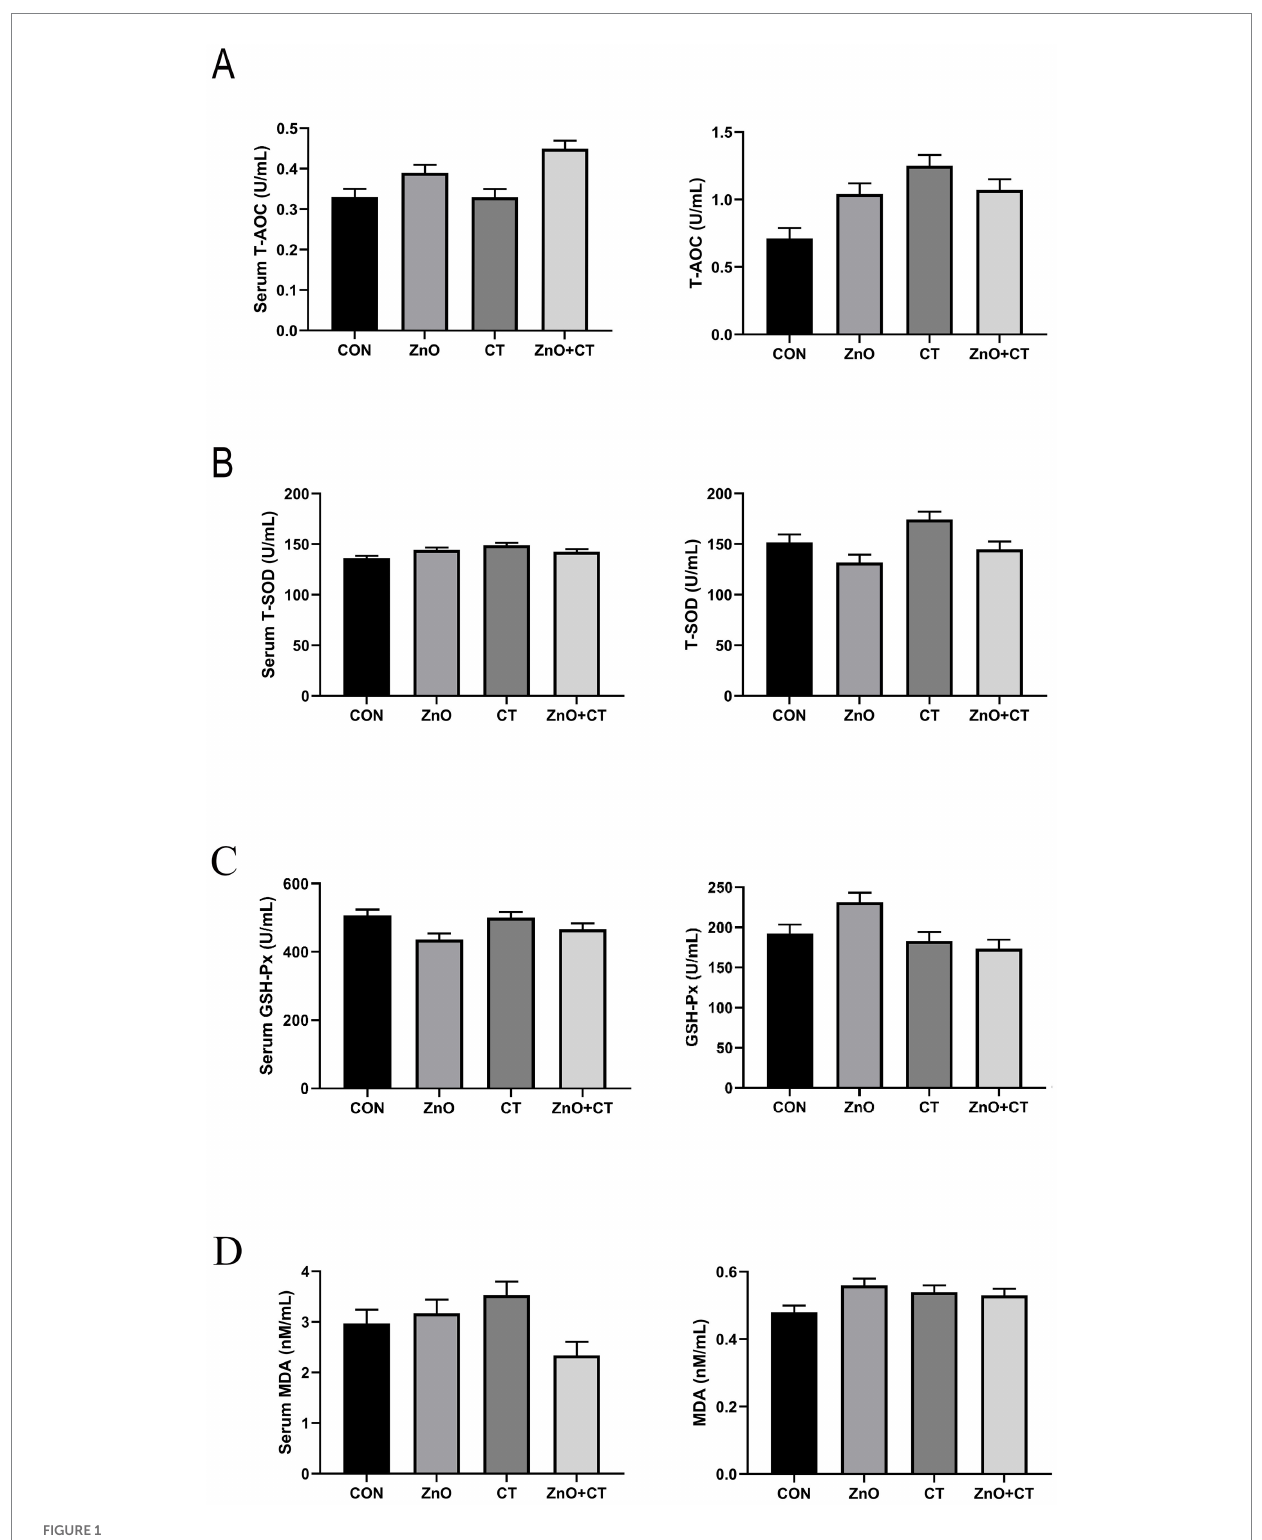
FIGURE 1 Effects of ZnO and CT on serum and liver antioxidant capacity of weaned piglets under K88-challenged environment. (A) The concentrations of T-AOC in serum and liver. (B) The concentrations of T-SOD in serum and liver. (C) The concentrations of GSH-Px in serum and liver. (D) The concentrations of T-MDA in serum and liver. T-AOC = total antioxidant capacity; T-SOD = total superoxide dismutase; GSH-Px = glutathione peroxidase; MDA = malondialdehyde. Values are means and standard errors represented by vertical bars ( n =